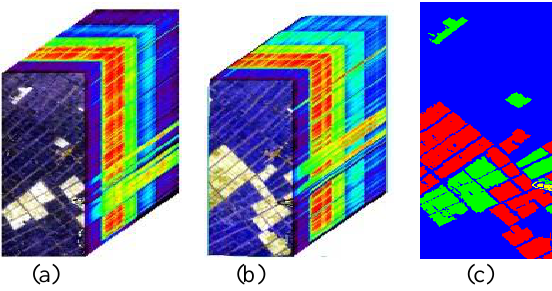
Figure 1. The (a) and (b) presented false-color composite of the original HSIs acquired in 2006 and 2007 of the China data set respectively, and (c) multiple change map ground truth.